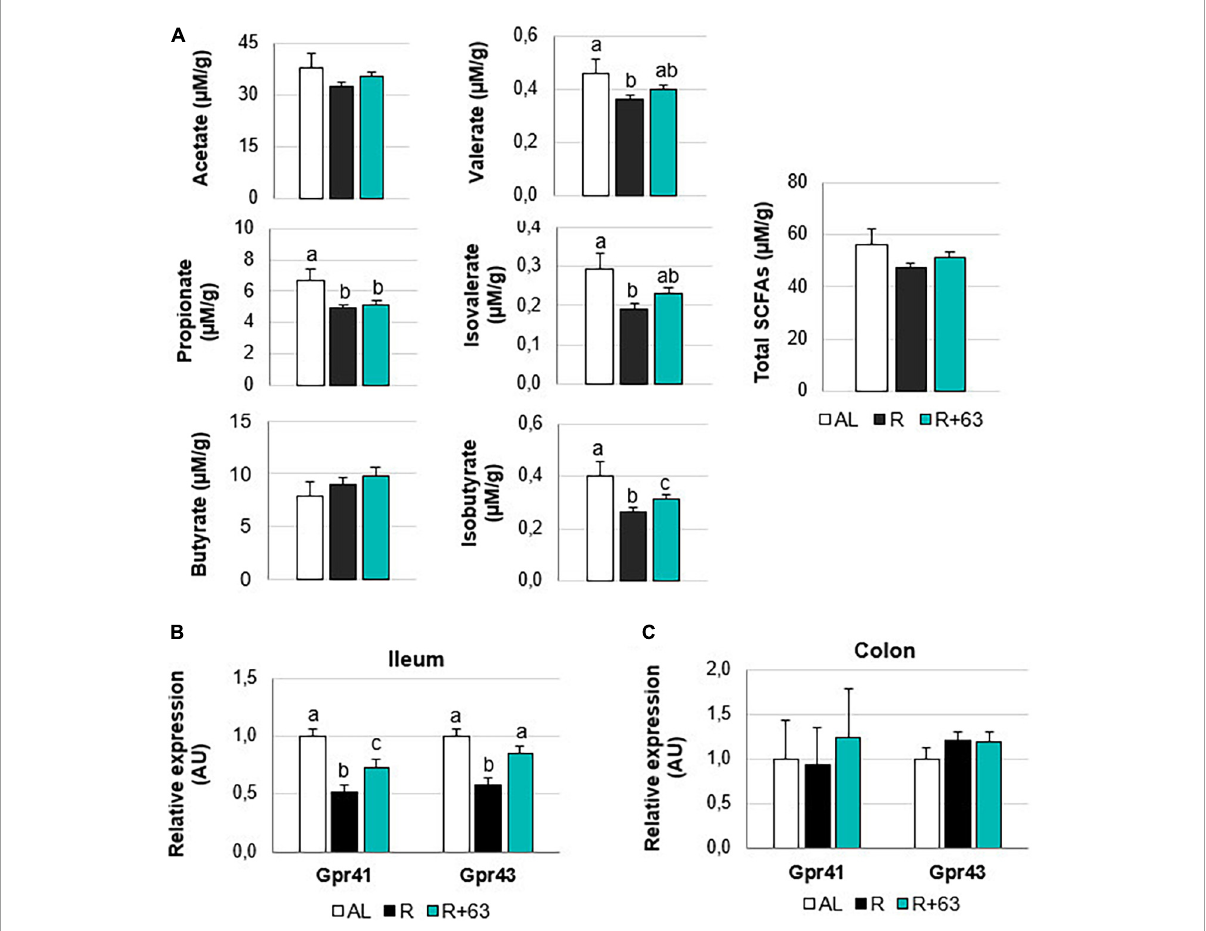
FIGURE7 Short-chain fatty acids levels in the cecal contents and expression of GPR41 and GPR43 in the colon and ileum of 18-month-old rats fed an ad libitum (AL) diet or a food-restricted (R) diet over 1-month period; one food-restricted group received a probiotic supplement – strain 63 (R+63). (A) Levels of the SCFAs acetate, propionate, butyrate, valerate, isovalerate, and isobutyrate in the cecal contents of the R and R+63 groups. (B) GPR41 and GPR43 expression in the distal ileum. (C) GPR41 and GPR43 expression in the proximal colon. Values are means ± SEM. Differences in letters indicate a significant difference between groups (Kruskal–Wallis test and Dunn’s post hoc test, p ≤ 0.05, n = 61